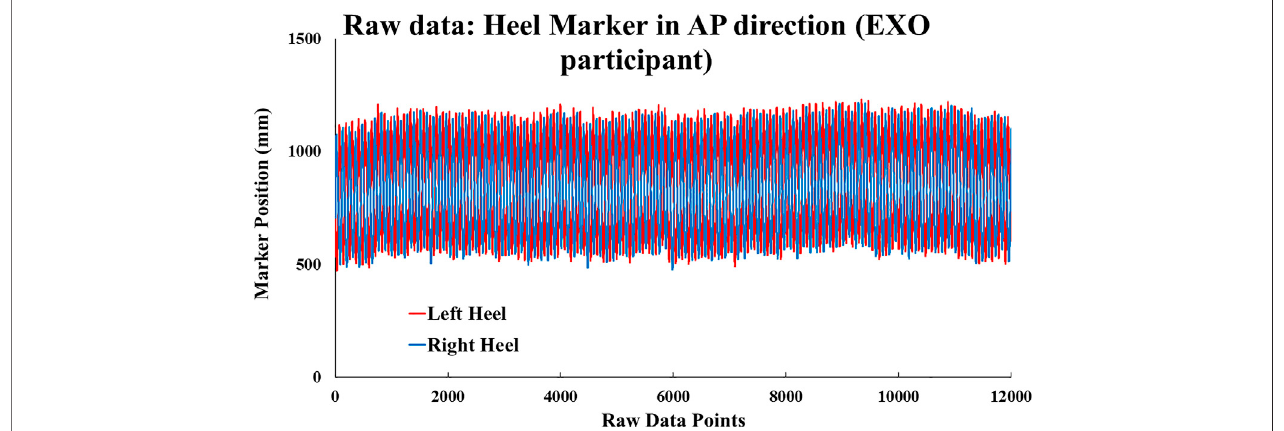
FIGURE 3 | Raw position data in mm of a representative participant ’ s right and left heel markers in the AP direction.